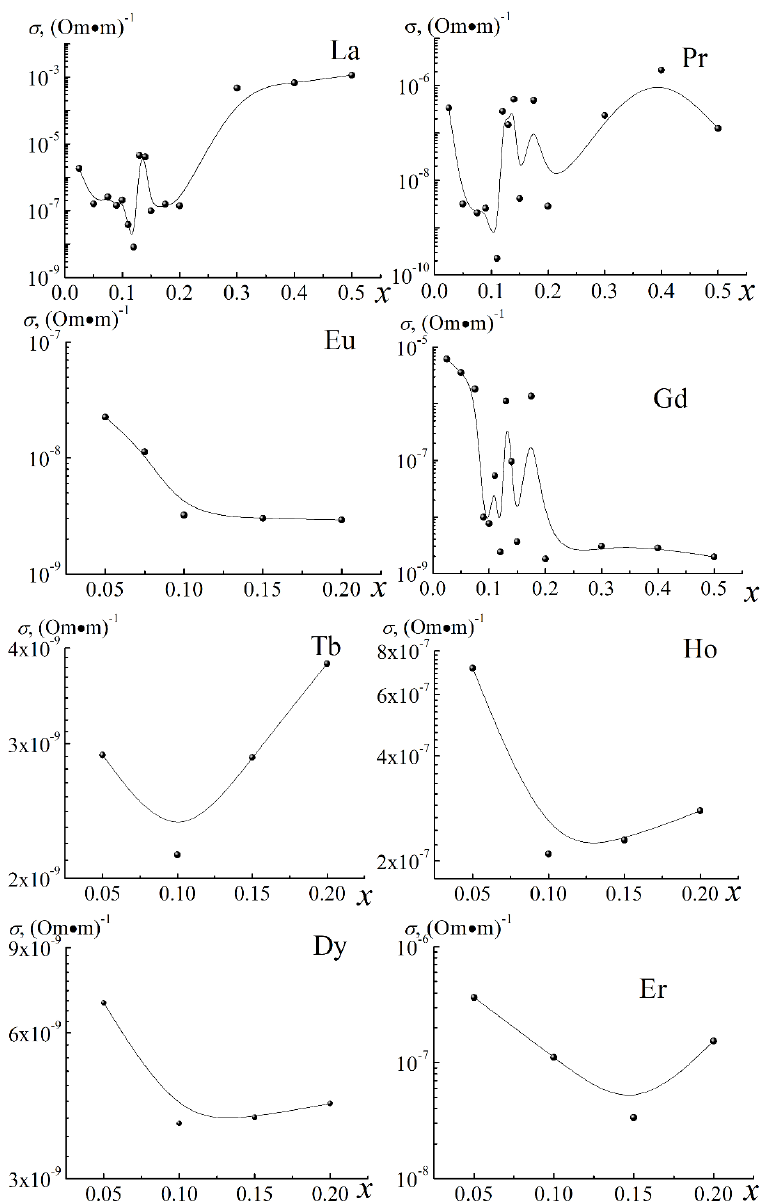
Figure 5. Dependences of the electrical conductivity σ of BiFeO 3 /REE–La, Pr, Eu, Gd, Tb, Ho, Dy, Er on the concentration of introduced x of REE (experimental points are marked with markers; solid lines serve as a guide to the eye).